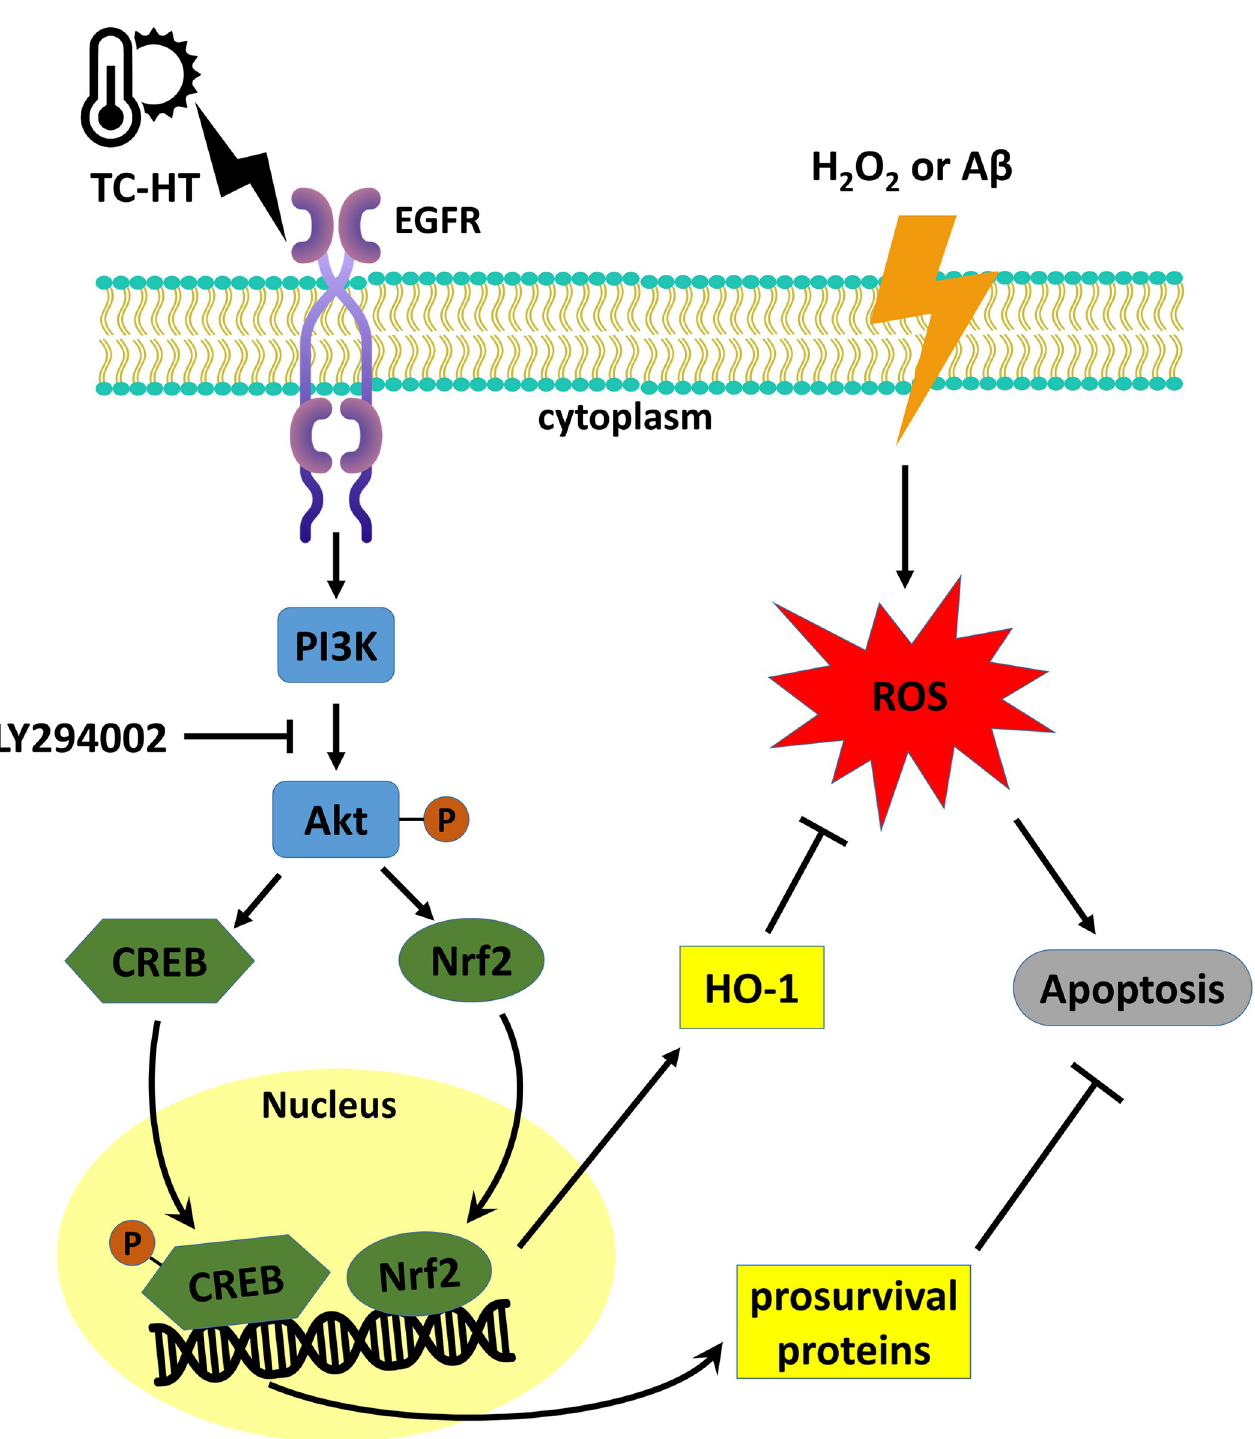
Fig 10. The proposed mechanisms for the protective effect of TC-HT against H 2 O 2 or A β -induced neural injury. The epidermal growth factor receptor (EGFR) in the cell membrane could be the upstream receptor sensing extracellular TC-HT stimulation and transmit the signal to activate the PI3K/Akt pathway, which induces Nrf2 and CREB activations. The transcription factors entering the nucleus further enhance the expressions of HO-1 and other prosurvival proteins which decrease the ROS level and inhibit the apoptosis signal.